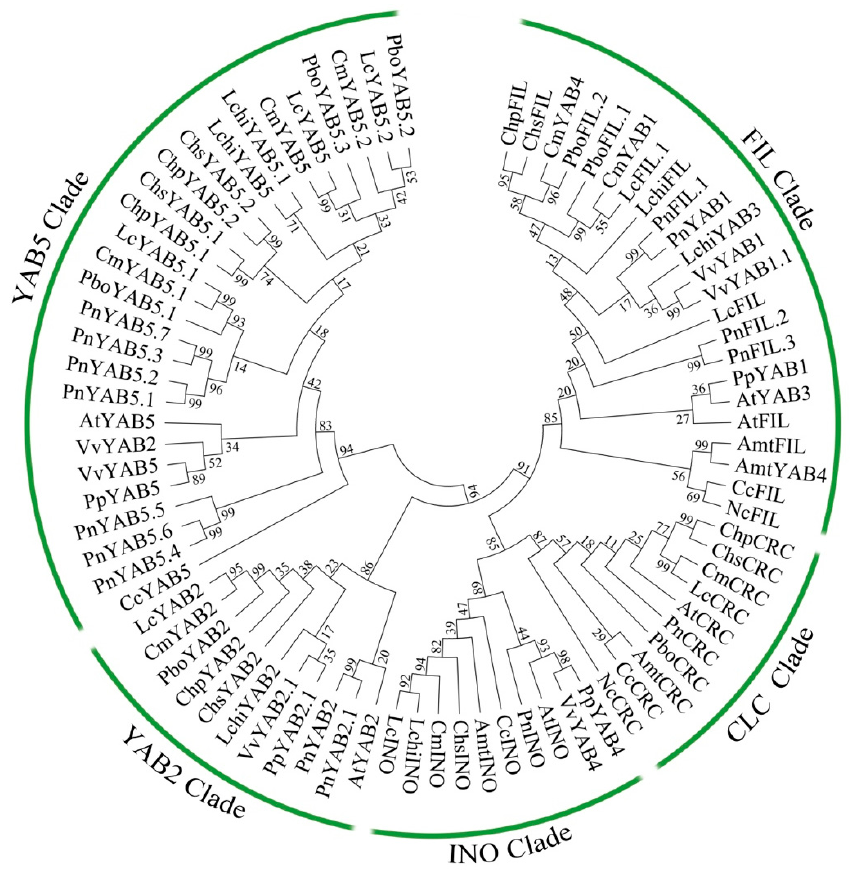
Figure 3. Phylogenetic tree of YABBY proteins from magnoliids and other angiosperms. The phylogenetic tree was constructed with the neighbor-joining (NJ) method using MEGA 7.0 software and was divided into five subgroups. The same acronym represents the same species: Cm: C. micranthum ; Chp: C. praecox ; Lc: L. cubeba ; Chs: C. salicifolius; Pbo: P. bournei ; Pn: P. nigrum ; Lchi: L. chinense .